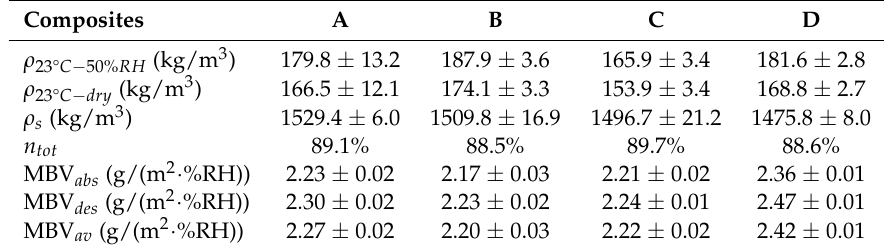
Table 2. Physical characteristics of composites: apparent density at 23 °C, 50%RH, and 23 °C, dry state, skeleton density, porosity, and moisture buffer value (MBV) in absorption, desorption, and average [14]. Composites A B